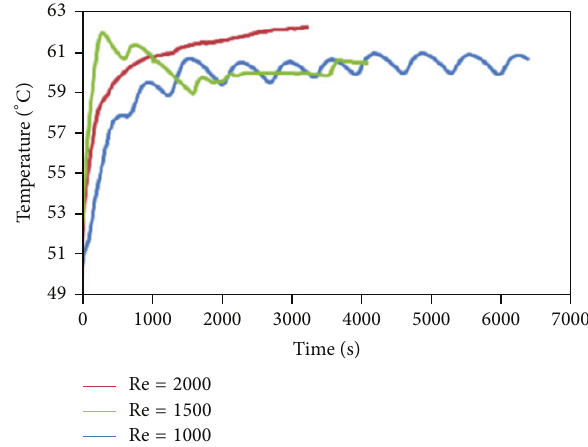
Figure 3: Temperature measurement records in the melting process for Re = 1000, Re = 1500, and Re = 2000.